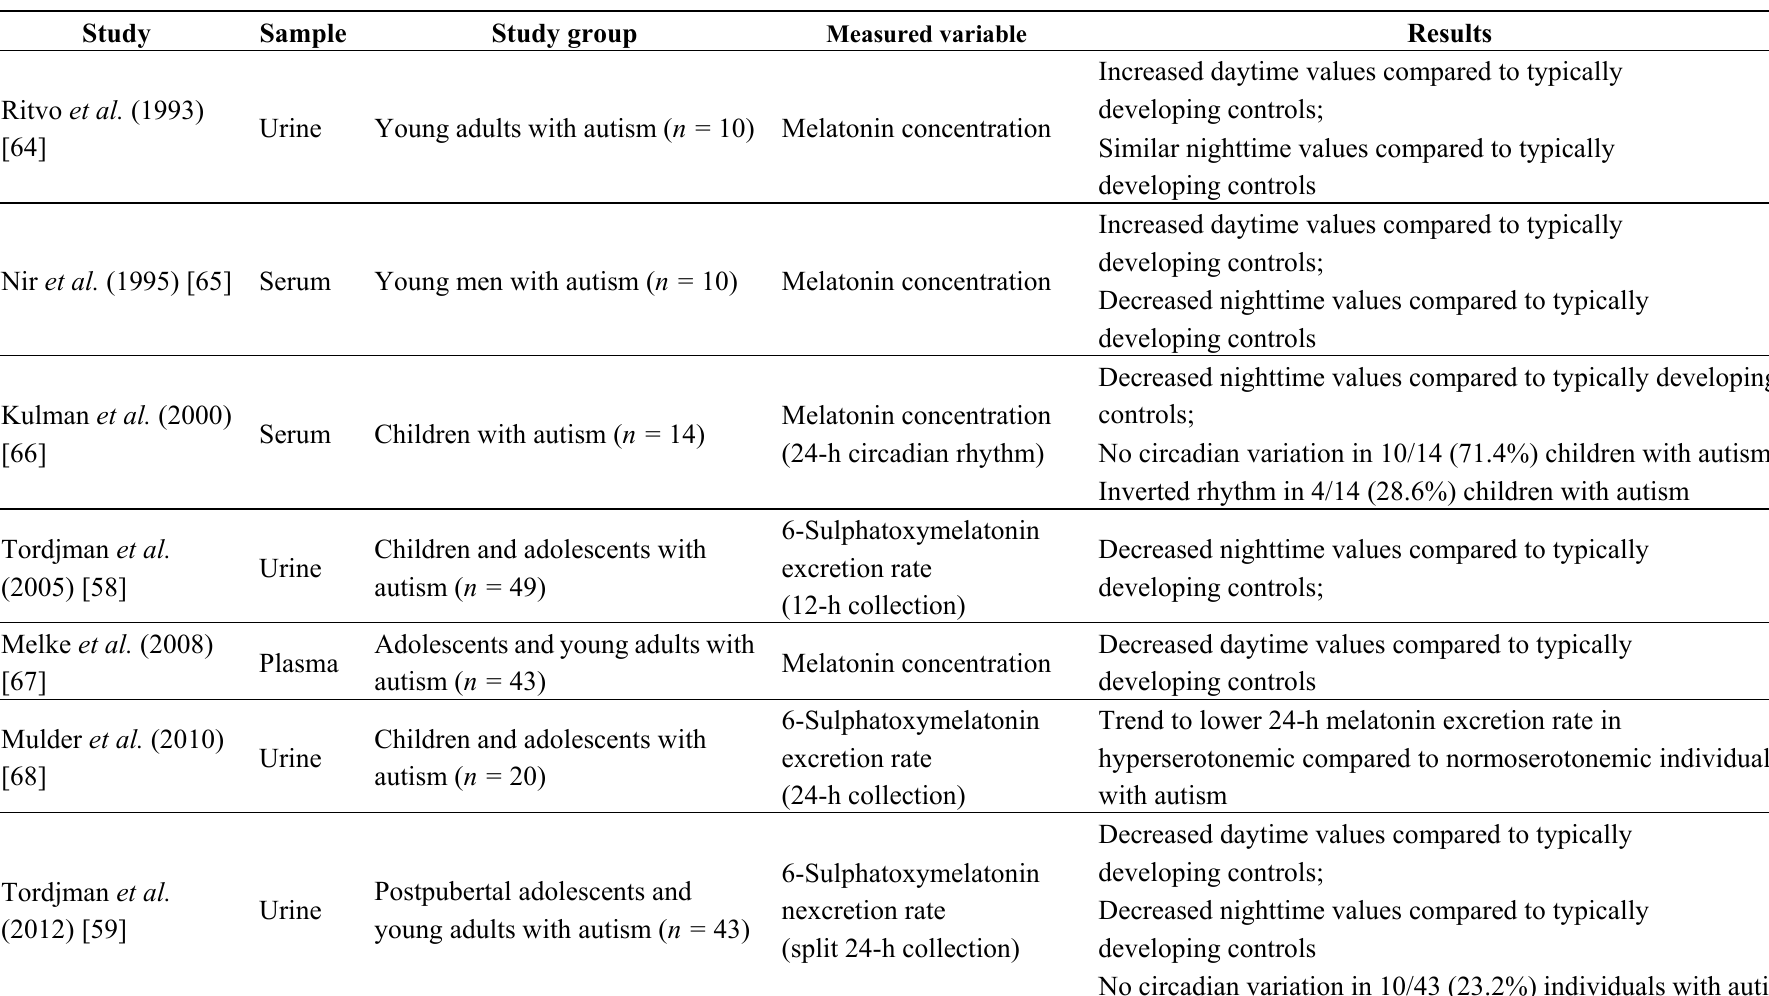
Table 1. Studies of melatonin in individuals with